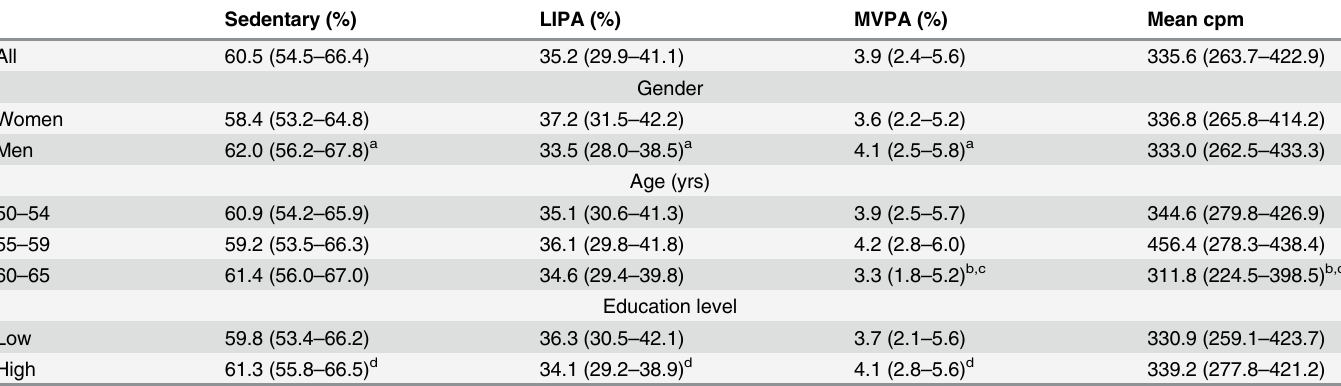
Table 2. Daily movement pattern (% of wear time in different intensity categories) and mean cpm among all study participants and in